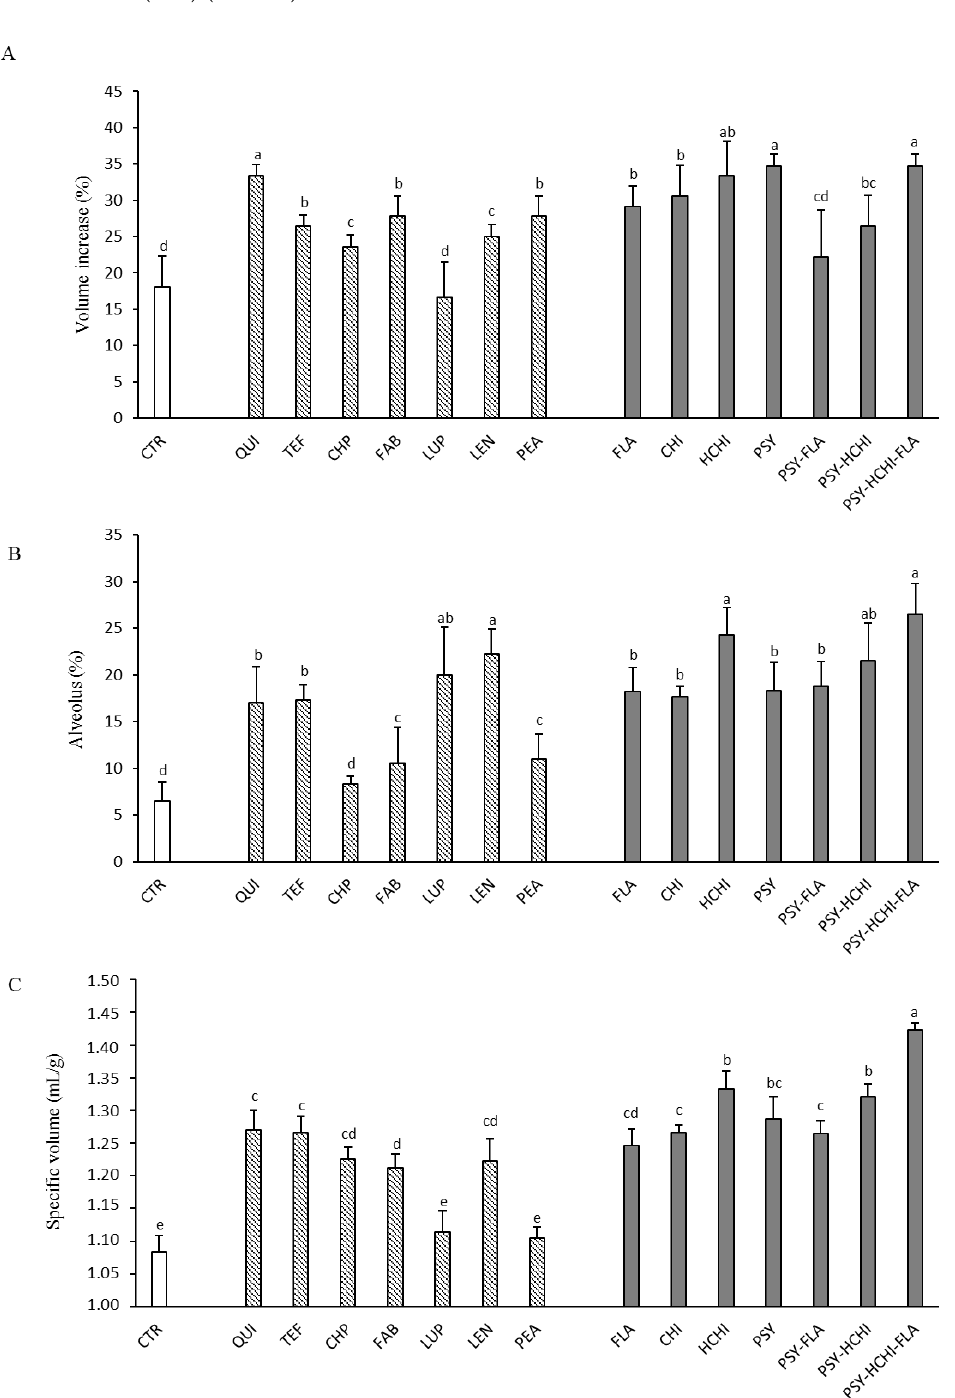
Figure 1. Evaluation of leavening performances on dough and bread made with rice and corn flours and supplemented with 10% of protein-rich ( ) and structuring ( ) flours (QUI, quinoa; leavening (2 h at 30 ◦ C); ( B ): Alveolus percentage of bread slice; ( C ): Specific volume of bread. a–e Bars with different letters differ significantly ( p <